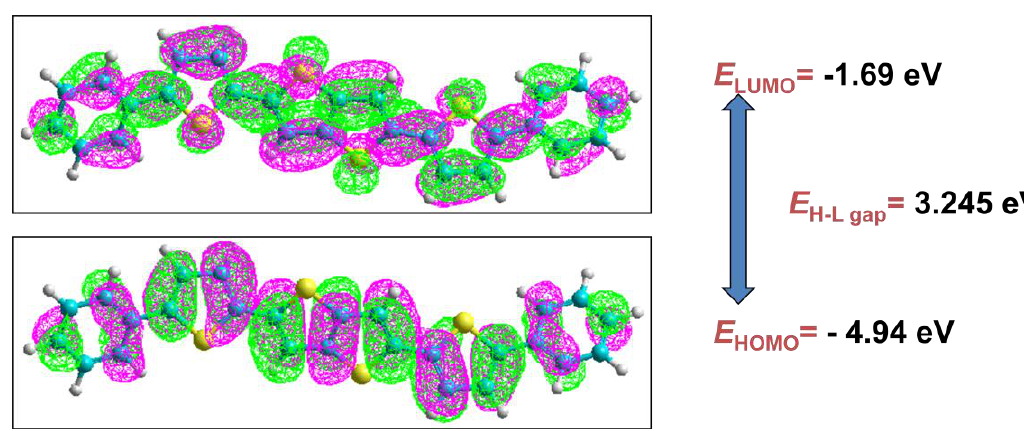
Figure 2. HOMO and LUMO Compound 3 .